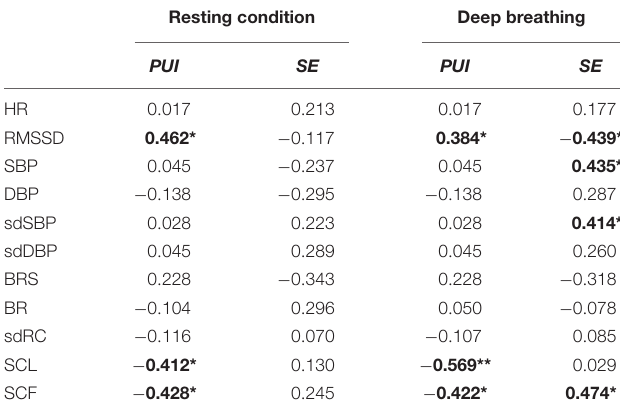
TABLE 6 | Correlation analysis of pupillary dynamics and autonomic indices at rest and deep breathing. Resting